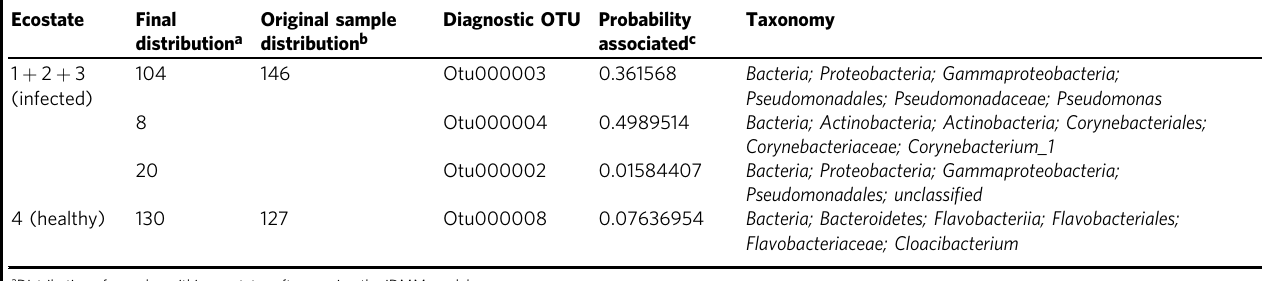
Table 2 Diagnostic microbes for each ecostate from the 2000th iteration of the iDMM model for the infected and uninfected humans.